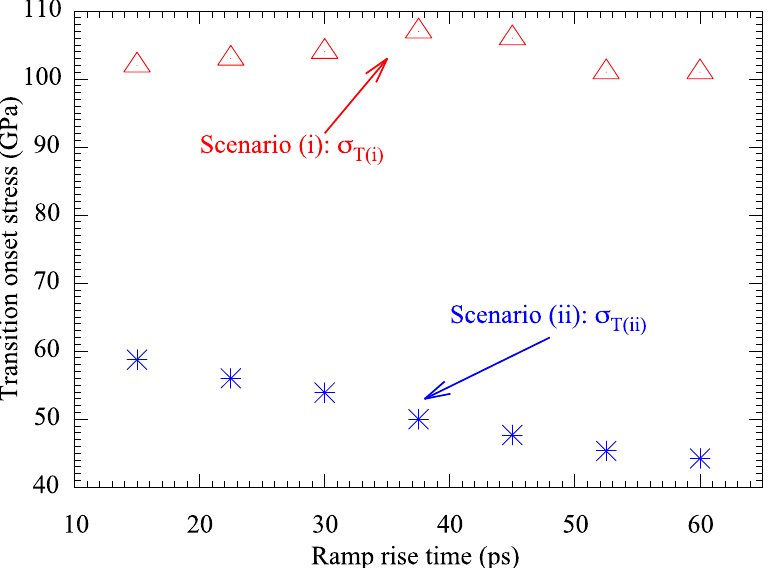
Figure 4. The structural 𝛼 to 𝜀 phase transformation onset stress as a function of the ramp rise time according to scenario (i) where high compression overcomes the hardening-like effect (red triangles) and scenario (ii) where the ramp wave steepens into a shock (blue stars).